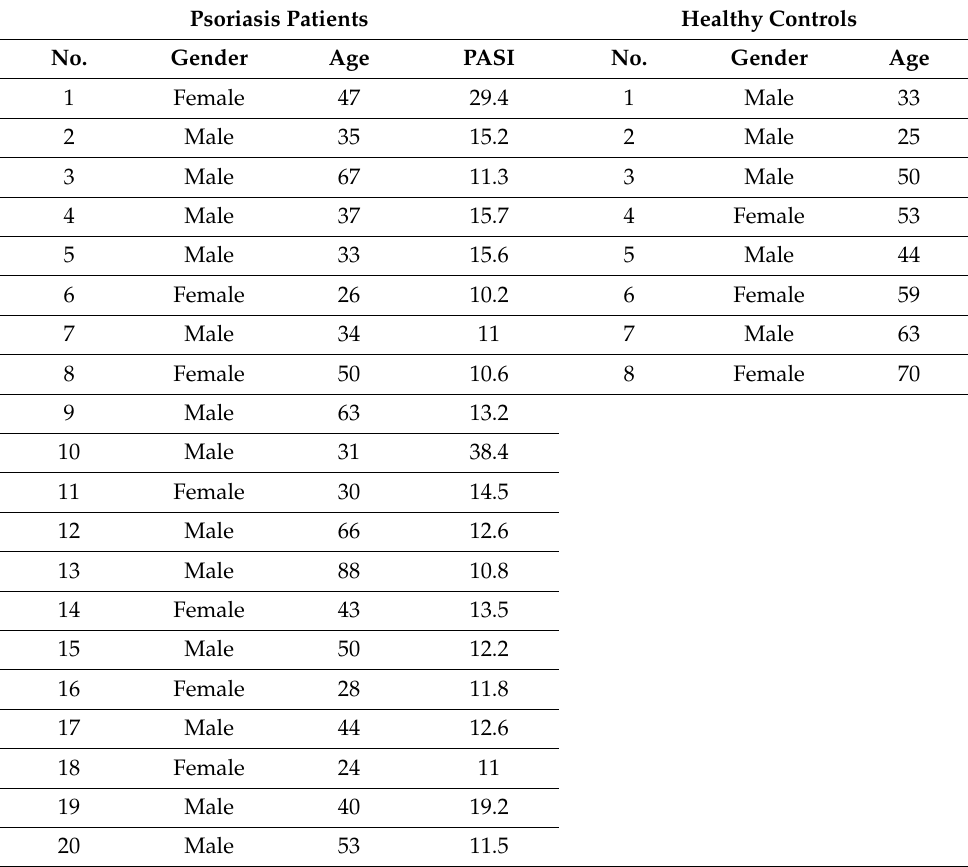
Table 1. Characteristics of psoriasis patients (PSO) and healthy controls (HC) studied in the discovery set. Psoriasis